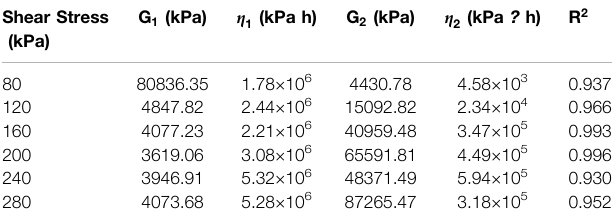
TABLE 2 | Parameters of the Burgers model. Shear Stress